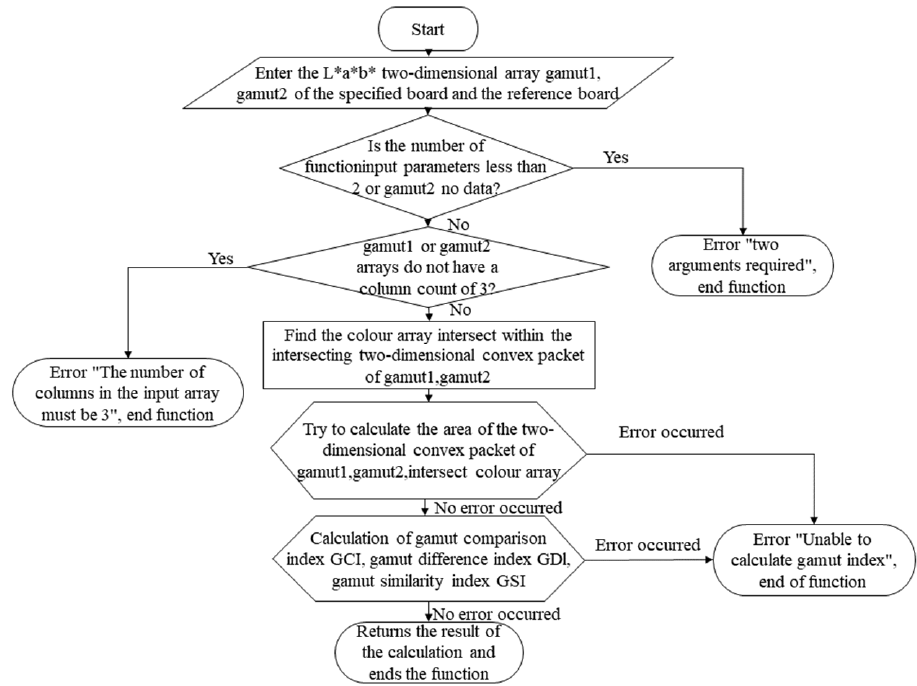
Figure 6. Compilation framework for color gamut comparison algorithms.